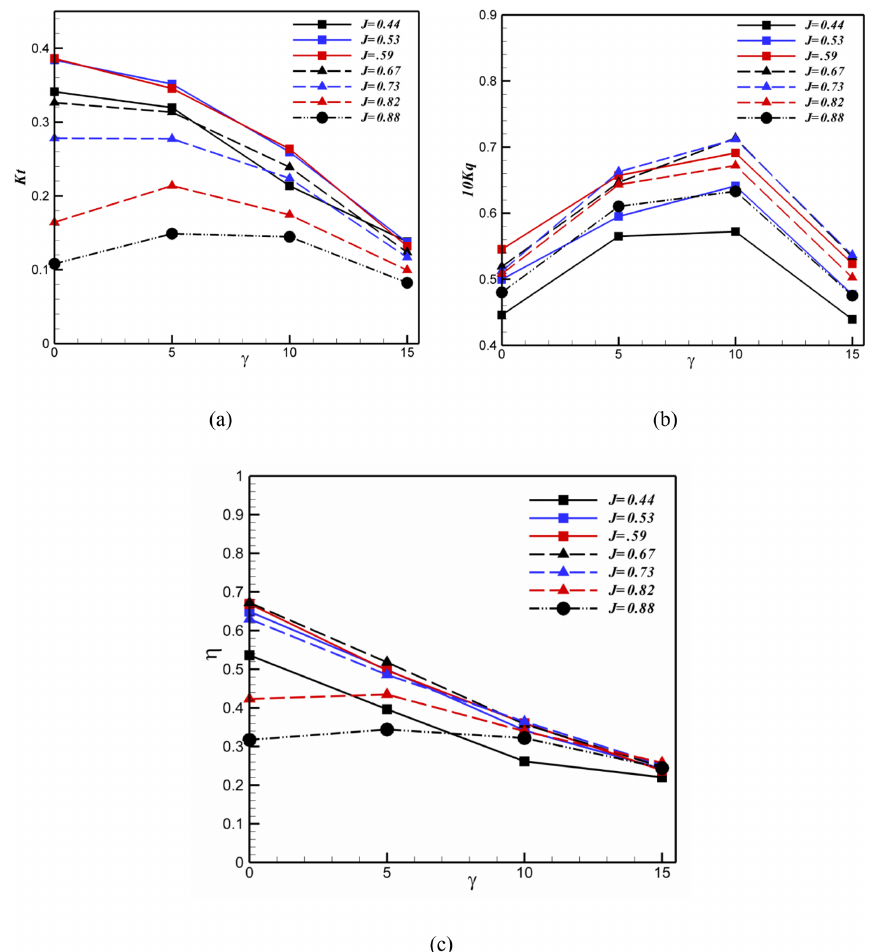
Figure 16. Effect of shaft inclination angle on the hydrodynamic coefficients and efficiency of the surface-piercing propeller at different advance coefficients and 60% immersion ratio.